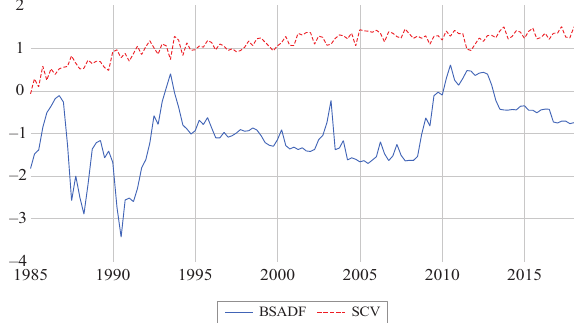
Figure 6. BSADF test using user costs and rental costs (the overall housing market)